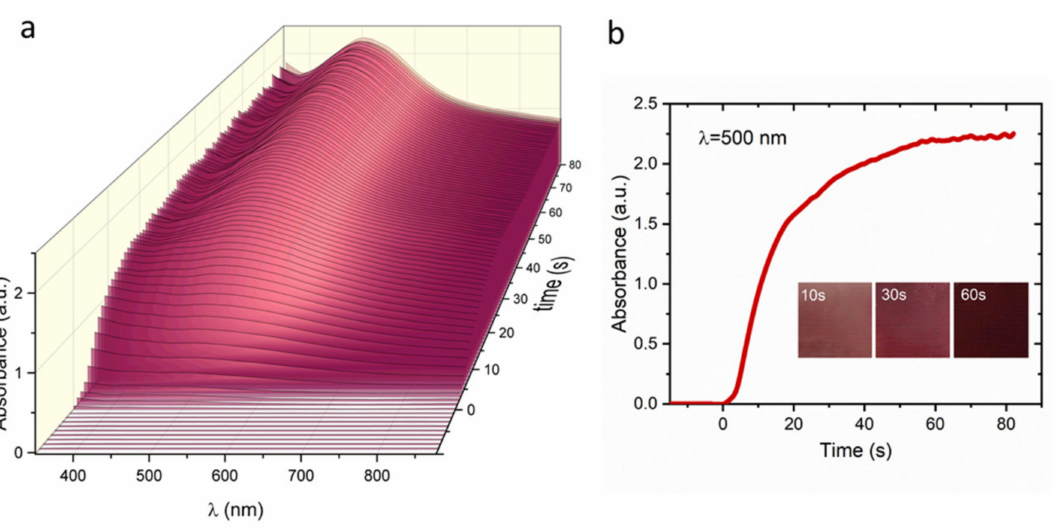
Figure 4. ( a ) UV-visible spectra obtained for [Fe II (H 2 O) 2 ] 2 [Nb IV (CN) 8 ] · 4H 2 O film during the ion-exchange synthesis; ( b ) Time dependence of the absorbance of the film at the wavelength of 500